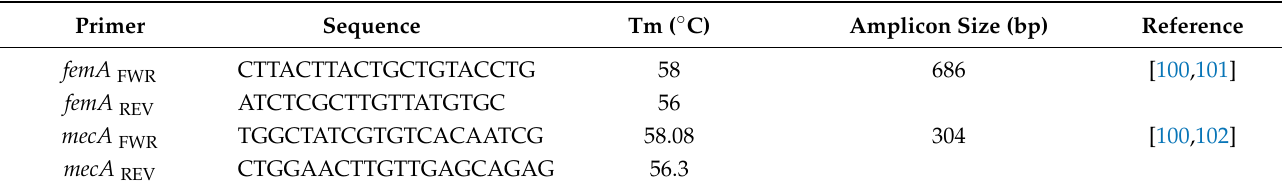
Table 6. PCR primers